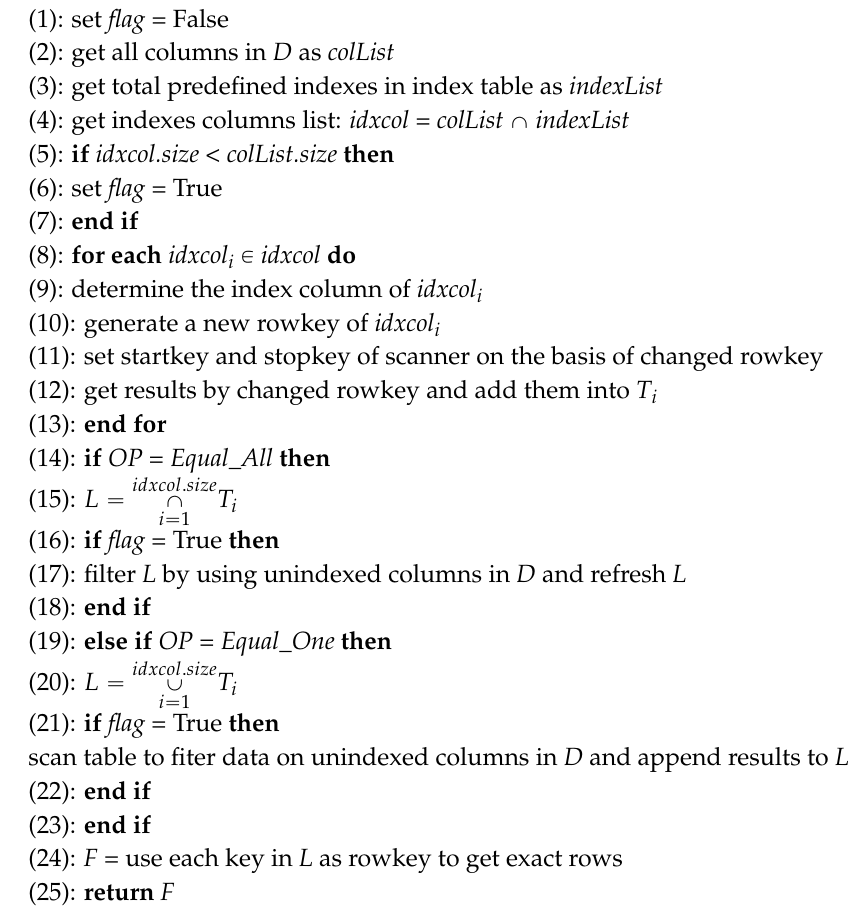
Algorithm 2. The Indexed Retrieve Algorithm